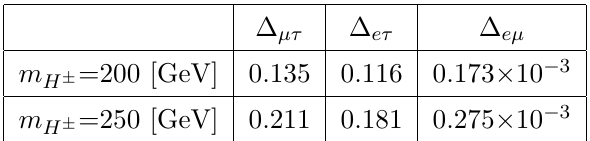
Table 3 . The upper bounds on 250 GeV. (cid:1) ll 0 = P